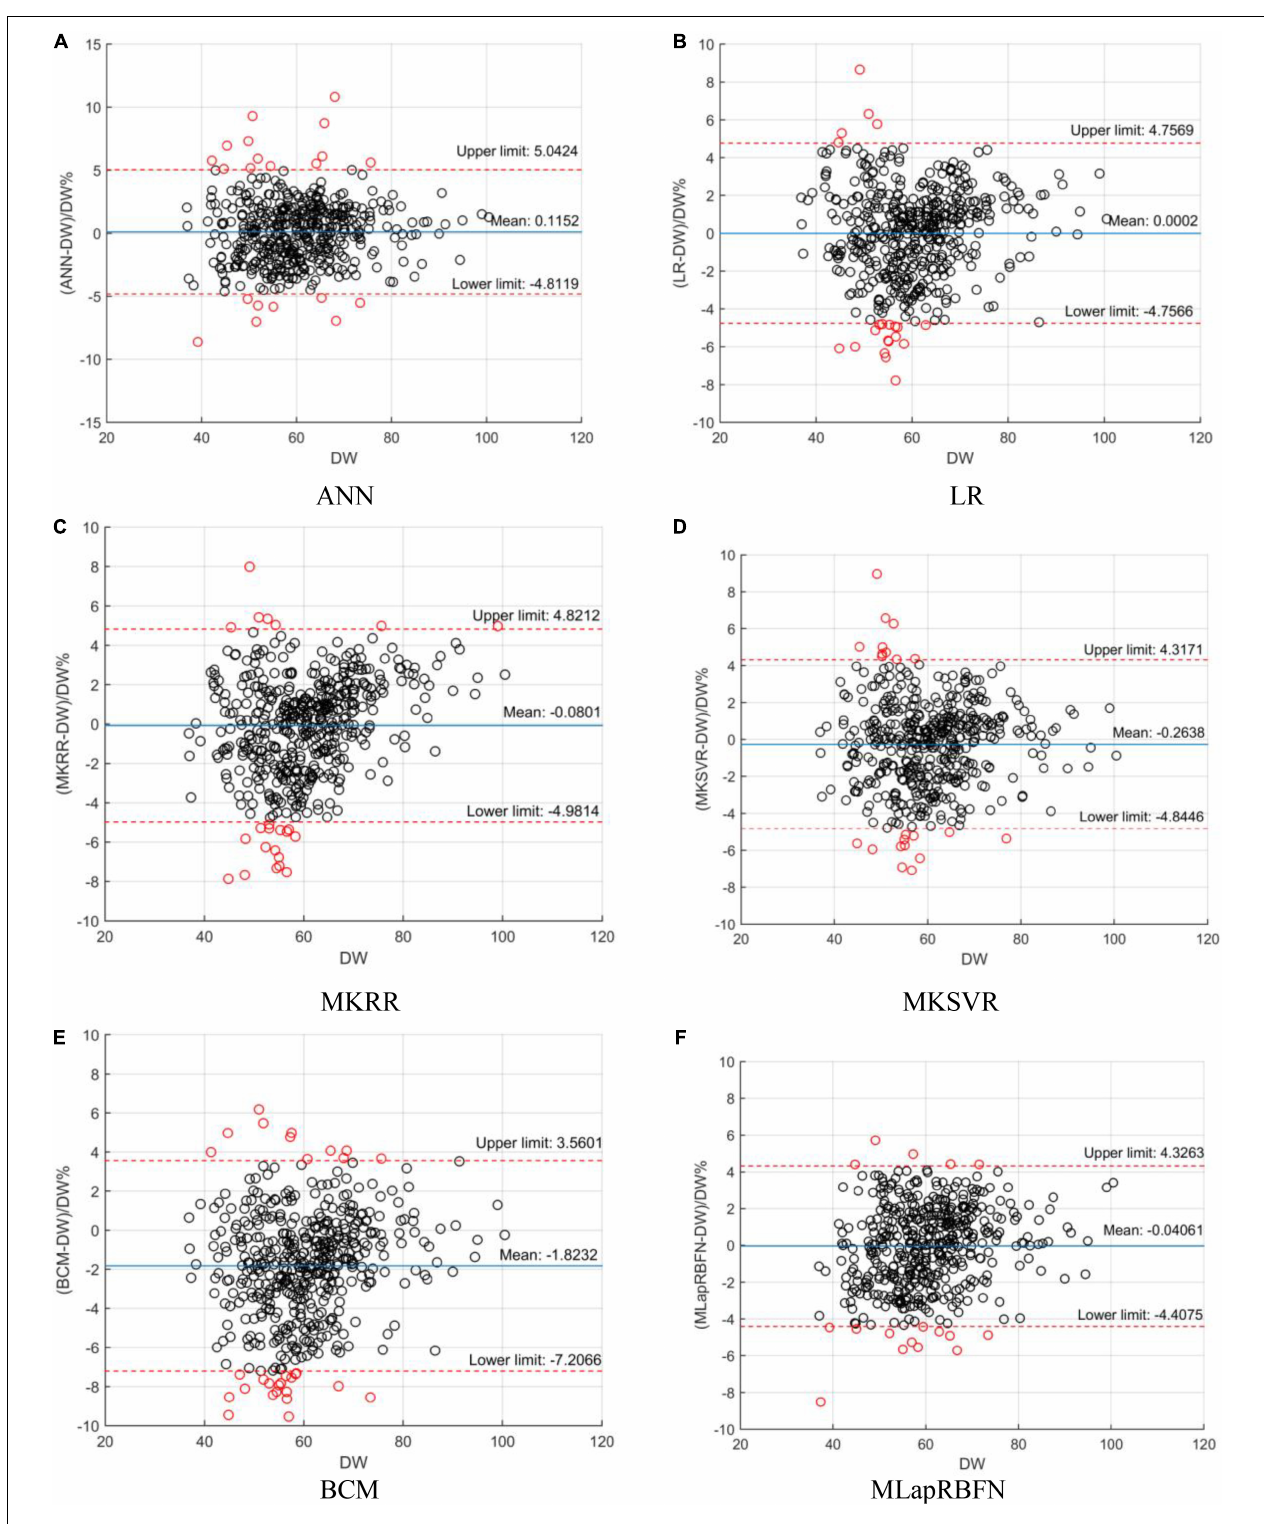
FIGURE 6 | Bland–Altman plot analysis. (A) ANN, (B) LR, (C) MKRR, (D) MKSVR, (E) BCM, and (F) MLapRBFN.